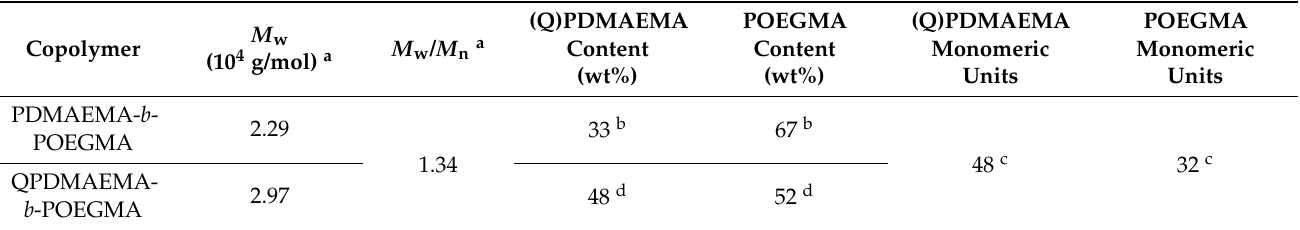
Table 1. Molecular characteristics of PDMAEMA- b -POEGMA and QPDMAEMA- b -POEGMA copoly-